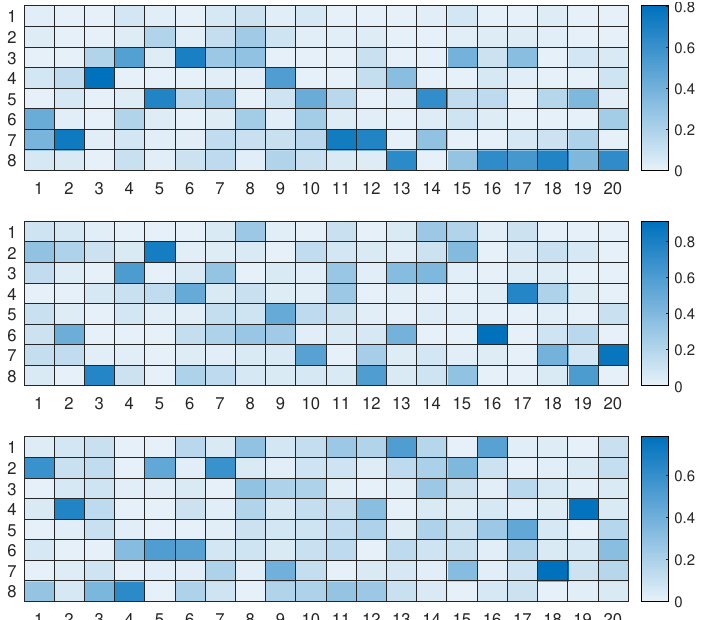
Figure 9. Average of the selected model structures for the CIFAR-100 test datasets in Scenario 2 under three different computational budgets ( c = 3), which decrease from top to bottom. The backbone architecture was ResNet-42, which contains 20 ResBlock-Ms, indicated on the x axis. The number of building blocks was three, and thus we had eight choices for the building blocks in each